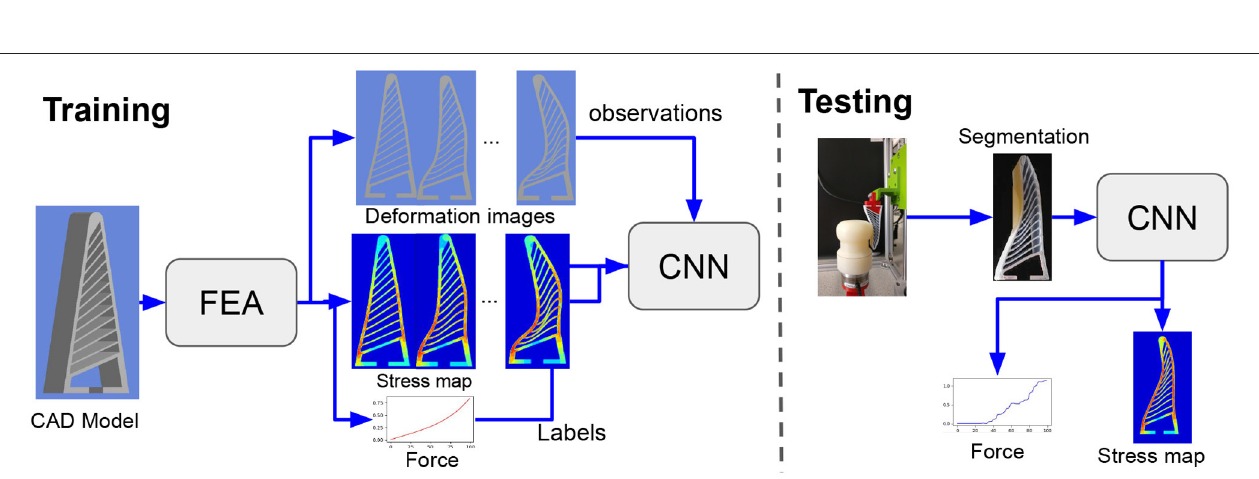
FIGURE 2 | Pipeline: In this work we aim to learn the contact force and stress maps for a fin ray finger using visual input from an external camera. We employ images captured via the FEA simulation of the gripper to train our deep network. Once trained, the network could be employed to predict forces and stress in real time from the deformation